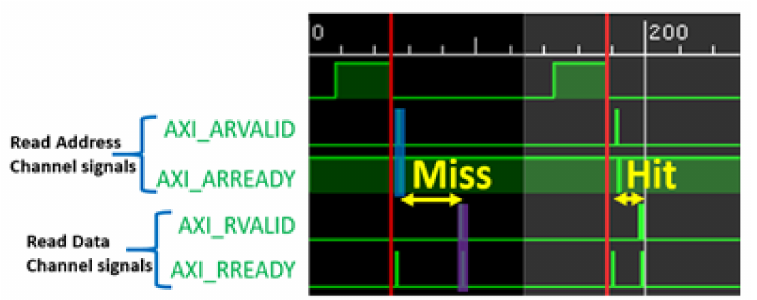
Figure 6. Read request, cache miss followed by a cache hit captured using Xilinx Vivado hardware debug tools.